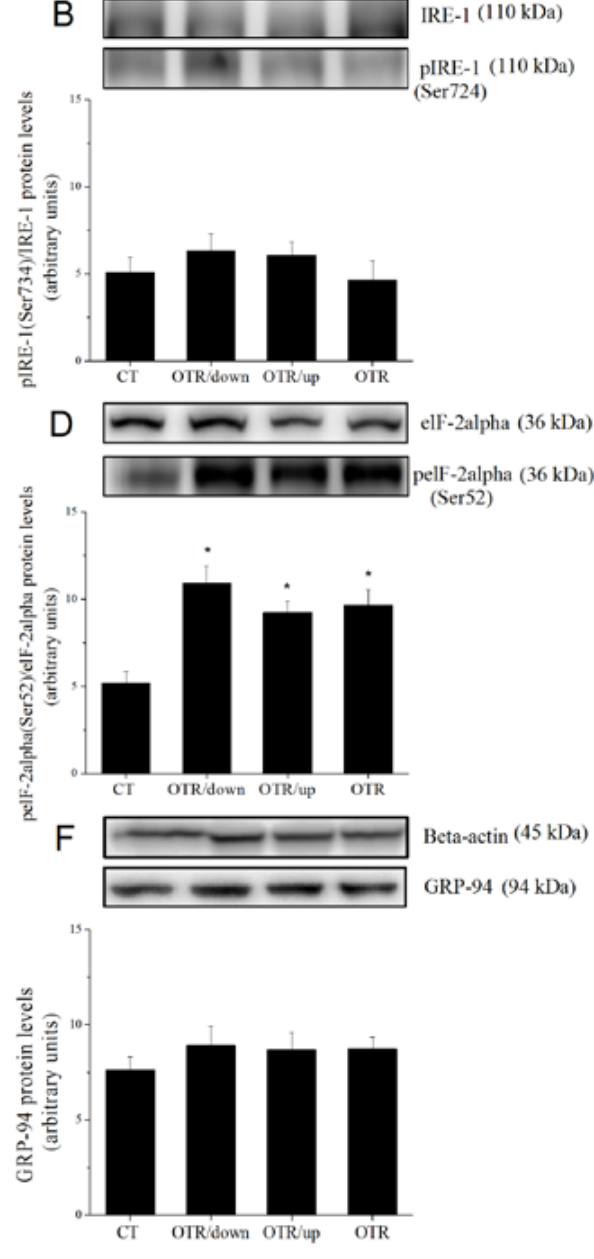
Figure 1. The responses (arbitrary units) of BIP relative to beta-actin (Figure 1A), pIRE1 (Ser734)/IRE1 (Figure 1B), pPERK (Thr981)/PERK (Figure 1C), and peIF2alpha (Ser52)/eIF2alpha (Figure 1D); ATF-6 relative beta-actin (Figure 1E); and GRP-94 relative to beta actin (Figure 1F) were measured in the hypothalamus of the experimental groups at the end of 10 weeks. Data correspond to the means ± SE of n = 6 mice. CT: sedentary mice; OTR/down: overtrained by downhill running; OTR/up: overtrained by uphill running; OTR: overtrained by running without inclination.*P < 0.05 vs. CT. **P < 0.05 vs. all